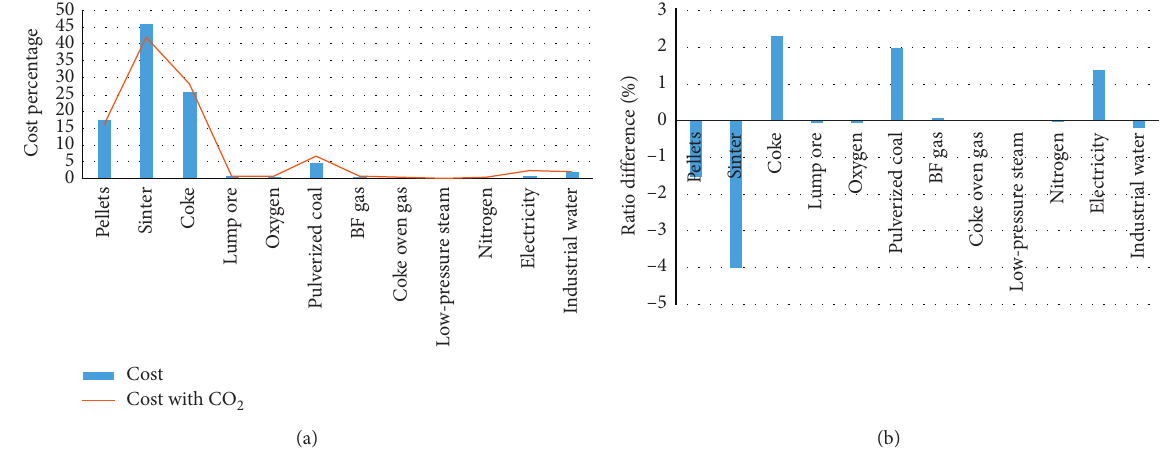
Figure 4: (a) Cost percentage of each stream. (b) Cost ratio